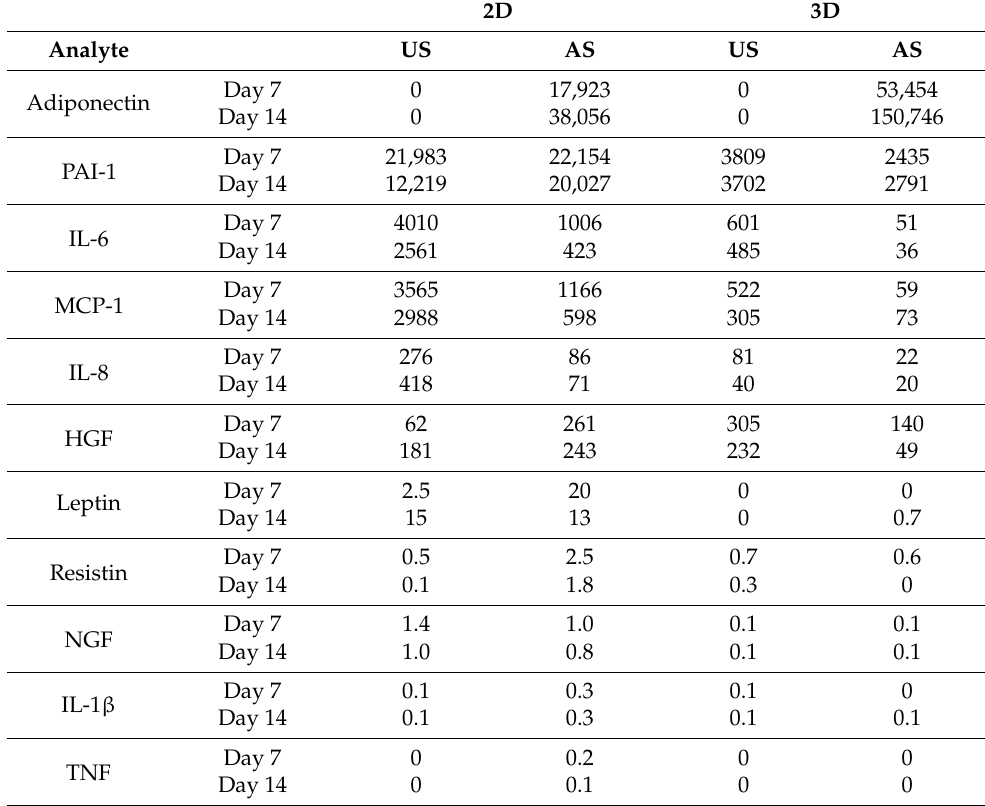
Table 1. Quantification of a subset of adipokines in cell culture supernatants of unstimulated (US) and adipogenically (AS) stimulated 2D and 3D cultures (multiplex assay, biological replicates: n = 4, technical replicates were involved in the calculations, median, values in pg/10 4 cells, descending order depending on detected quantity, with decimal place in the single-digit